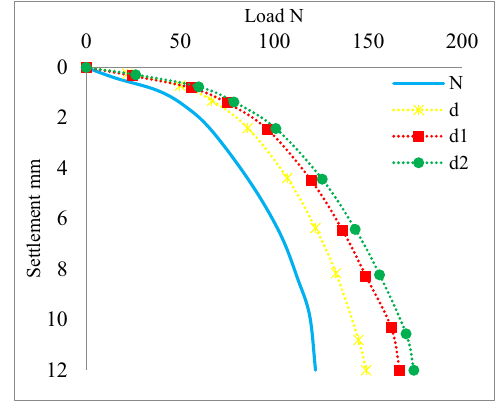
Figure 10: Load – settlement relations for footings resting on soil grouted underneath and around the footing.